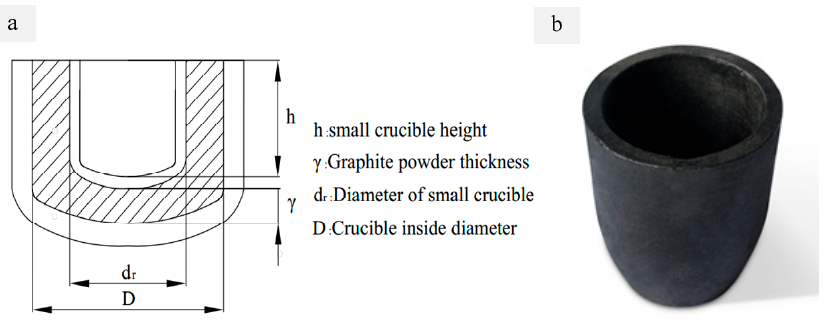
Figure 7. ( a ) Schematic diagram and ( b ) image of the improved crucible and molten pool struc- ture.